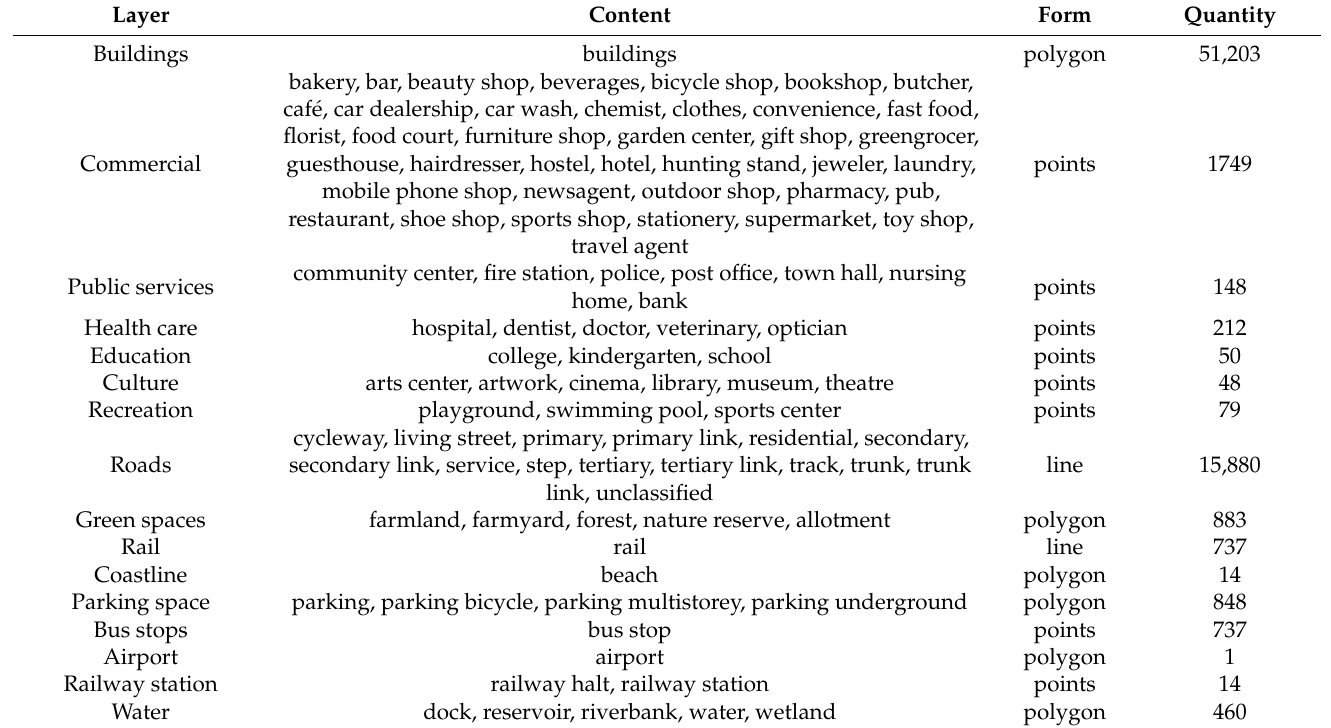
Table 1. Features of environment. Source: Renigier-Biłozor, et al. [58].